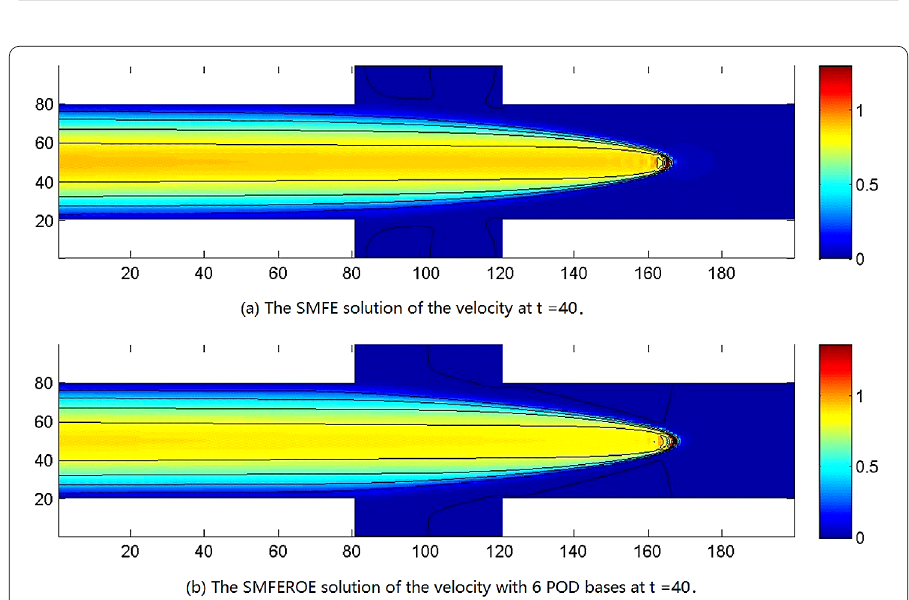
Figure 2 The numerical solutions of the velocity. (a) The SMFE solution of the velocity u at t = 40 when Re = 1,000 and Pr = 7. (b) The SMFEROE solution of the velocity u with 6 POD bases at time t = 40 when Re = 1,000 and Pr =